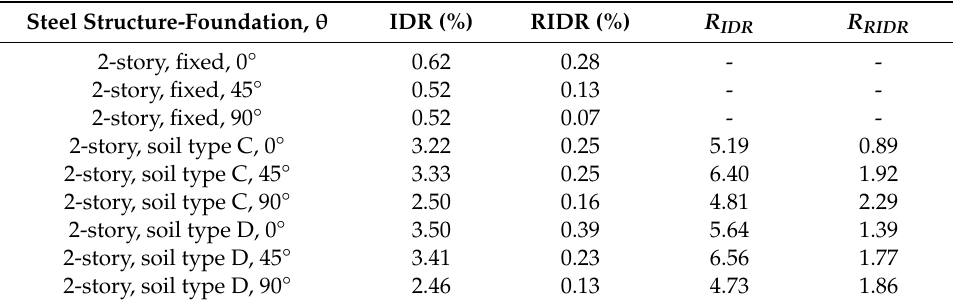
Table 6. Maximum IDR, RIDR, and R values of the 2-story steel structure-foundation systems. Steel Structure-Foundation, θ